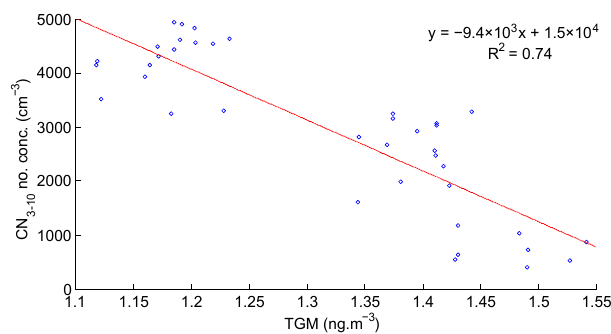
Figure 7. A negative linear correlation is found when CN 3 − 10 was time lagged by 2h relative to TGM, suggesting involvement of Hg in the nucleation chemistry. Data used show a 5h period, starting 18 October 02:00 for TGM and 04:00 for CN data. The data gap surrounding TGM concentrations of 1.3ngm − 3 is a result of rou- tine calibrations, which coincided with the period of interest, and resulted in a 90min